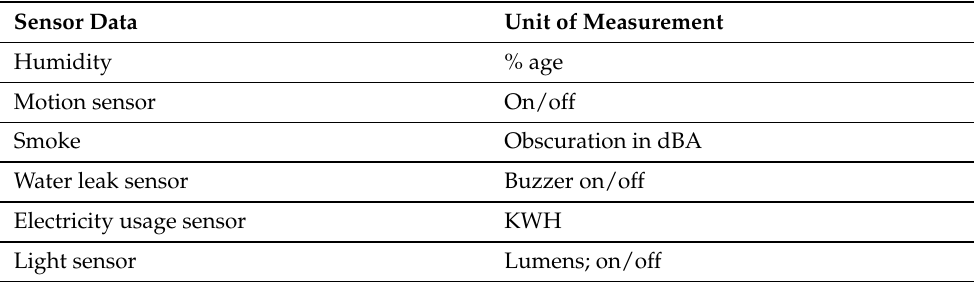
Table 5. IoT sensors’